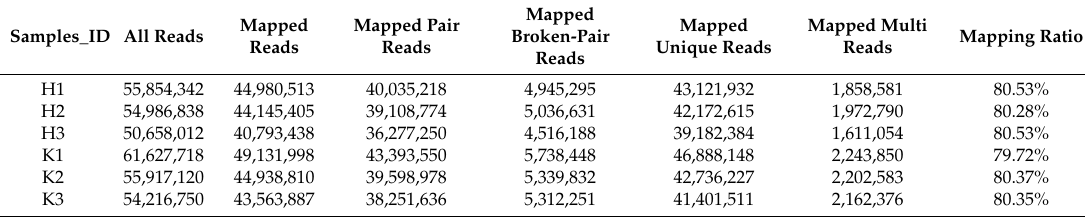
Table 1. Statistical summary analysis of RNA-seq datasets of infection cells and control cells.